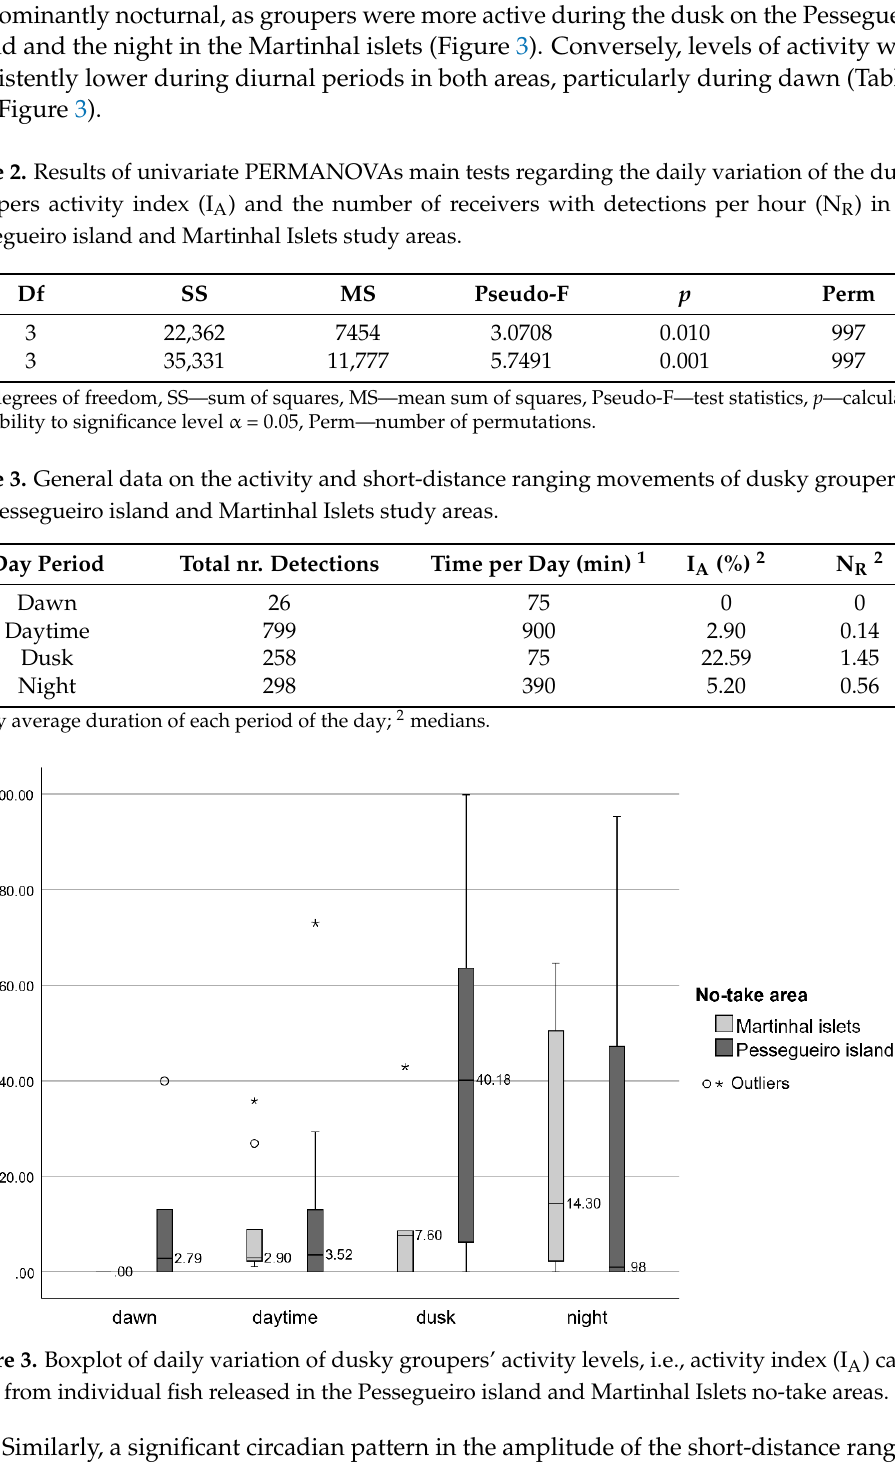
Figure 4. Boxplot of daily variation of the amplitude of movements, i.e., the number of receivers with detections per hour (N R ) calculated from individual fish released in the Pessegueiro island and Martinhal Islets no-take areas. On average, groupers moved for about 12 h before leaving the study areas, moving ca. 2.5 km, with a mean ranging speed of 590 m.h −1 (Table 5).